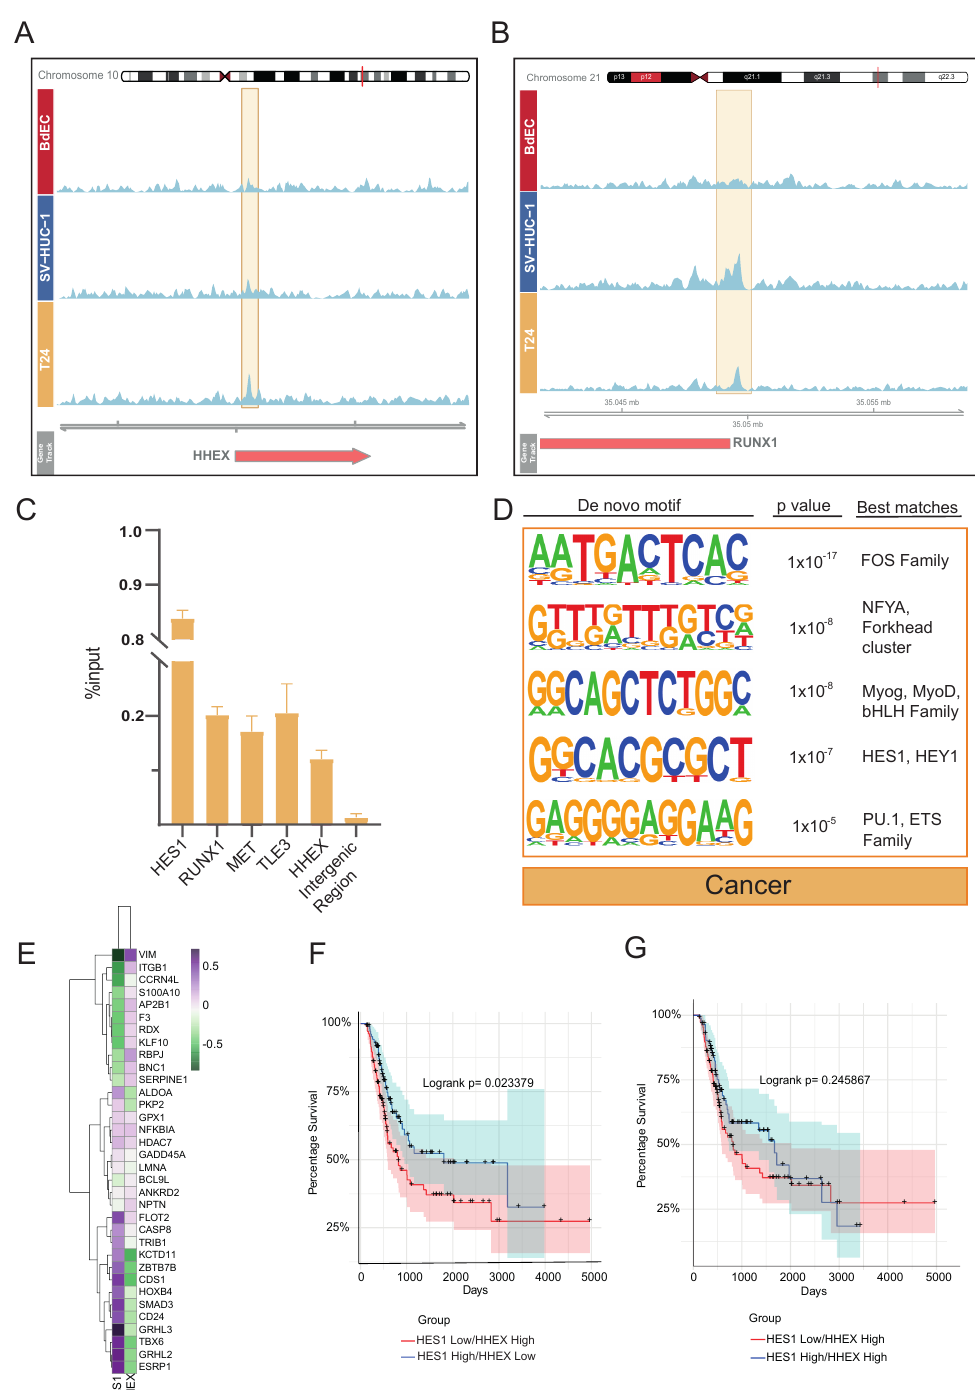
Figure 4. Genomic occupancy profile of truncated KDM6A in T24 bladder cancer cell line. ( A , B ) Snapshot images showing KDM6A signal in BdEC, SV-HUC-1, and T24 cell lines at HHEX ( A ) and RUNX1 ( B ) loci. ( C ) ChIP-qPCR analysis of KDM6A enrichment in T24 cell line at selected loci. ( D ) Transcription factor motif enrichment analysis of T24 KDM6A peaks linked with genes. ( E ) Heatmap demonstrates the correlation between the expression of HES1 , HHEX , and the genes involved in the regulation of developmental processes in primary bladder cancer. ( F ) Kaplan–Meier graph shows the overall survival of primary bladder cancer patients, grouped according to the ex- pression status of HES1 and HHEX . ( G ) Kaplan–Meier graph shows the overall survival of primary bladder cancer patients, grouped according to the expression status of HES1 with high ‘ HHEX ’